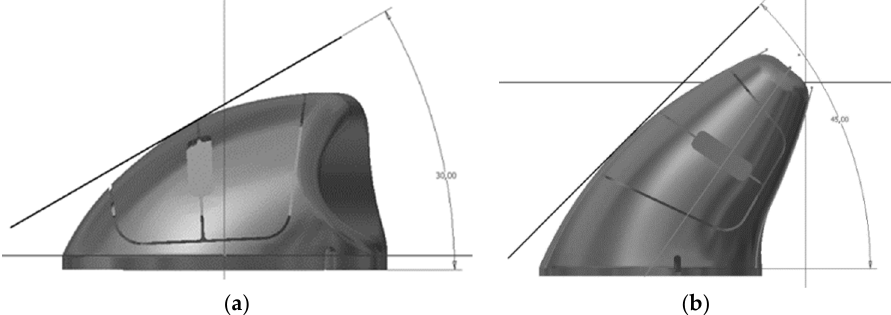
Figure 6. 3D CAD models (front view). ( a ) ch concept (slanted angle of about 30°); ( b ) ci concept (slanted angle of about 45°).